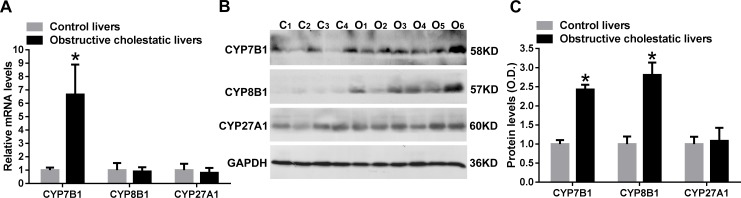
Levels of bile acid synthetic enzymes, CYP7B1 and CYP8B1, in liver samples of patients with obstructive cholestasis.A) Real-time qPCR analysis of CYP7B1, CYP8B1 and CYP27A1 mRNA levels in liver tissues of patients with obstructive cholestasis and controls. B) and C) Western blot analysis of CYP7B1, CYP8B1 and CYP27A1 protein levels in cholestatic livers and controls. Data were analyzed using independent samples t test. *: p < 0.01 vs. controls. C, controls, n = 22; O, obstructive cholestasis liver samples, n = 22.